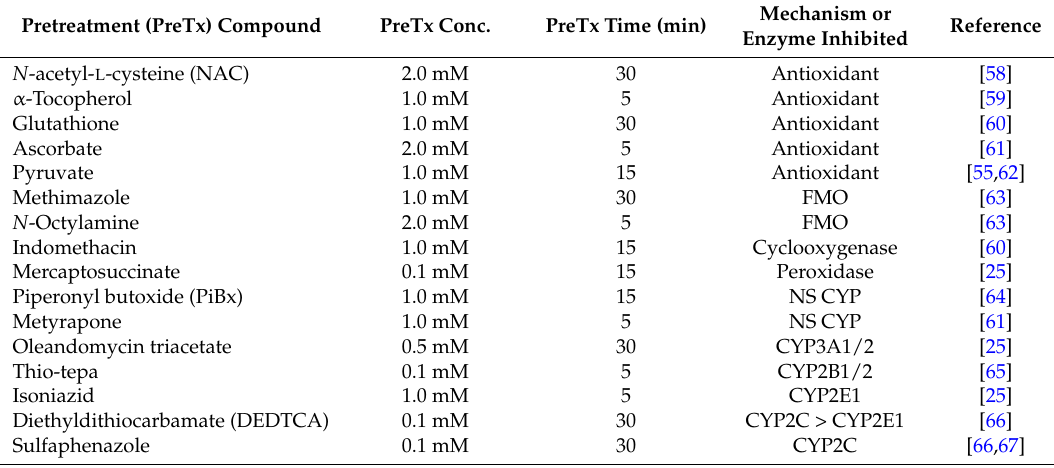
Table 5. List of pretreatment antioxidants and enzyme inhibitors with primary targeted enzyme systems. Pretreatment (PreTx) Compound PreTx Conc. PreTx Time (min)